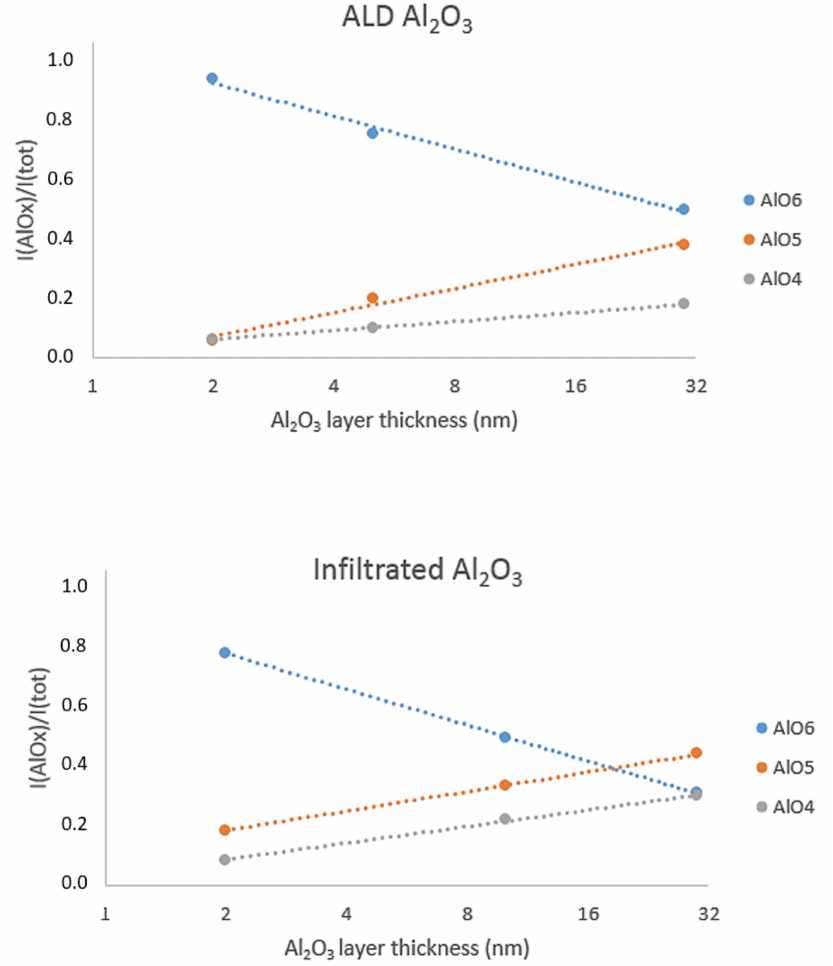
Figure 13. Aluminium coordination as a function of the layer thickness in Al 2 O 3 -infiltrated and -coated cellulose acetate